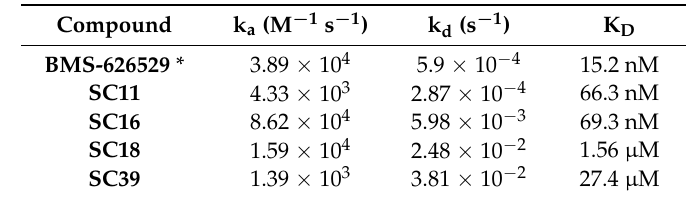
Table 2. Kinetics and affinity of BMS-626529 and the SC compounds binding to soluble, cleaved recombinant Env.